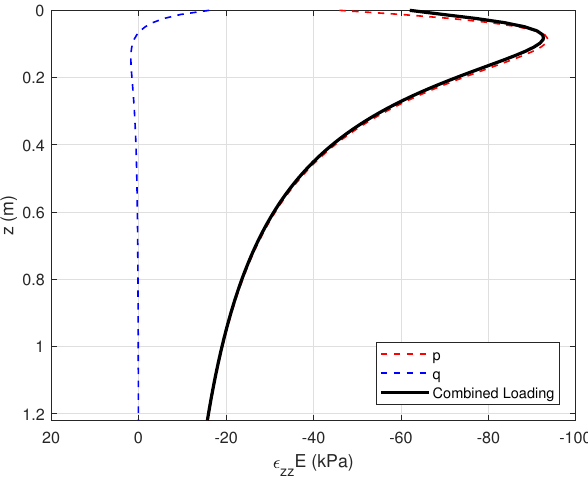
Figure 13. Calculated strains beneath the center of the examined load case from Bauer et al. [32] (Figure